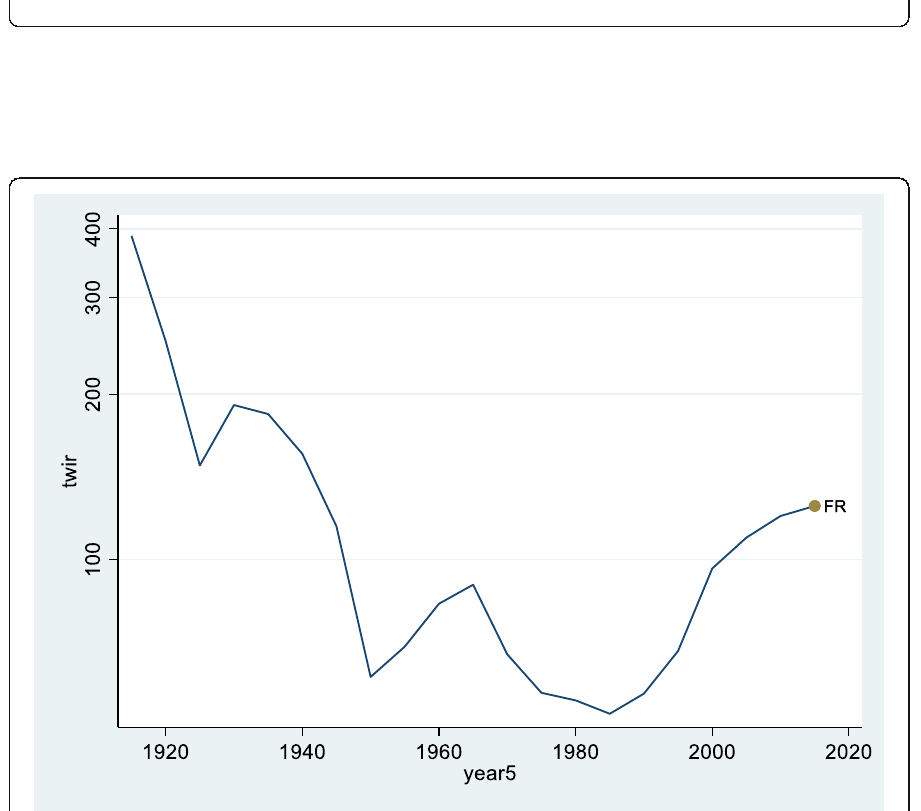
Fig. 3 Top wealth (average top 1% population ’ s net wealth) to average income ratio (TWIR) in France, 1913 – 2015 (logged y -scale). Source: Authors ’ calculations based on the WID database,